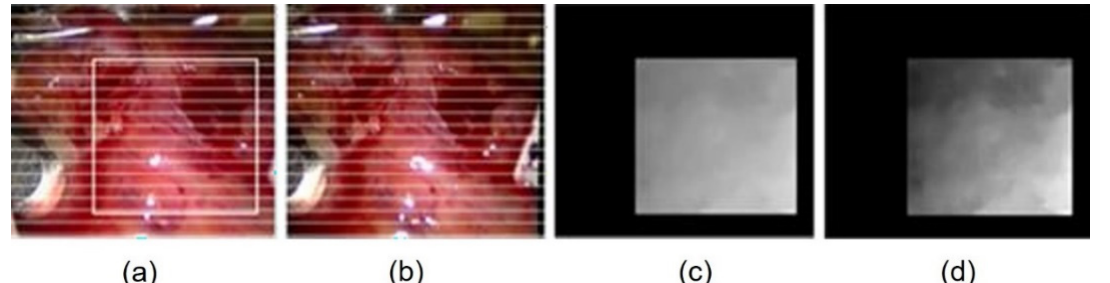
Figure 10. Stereo images of cardiac soft tissue and corresponding matching results. ( a ) Corrected left image; ( b ) corrected right image; ( c ) result parallax map; ( d ) enlarged posterior parallax map.